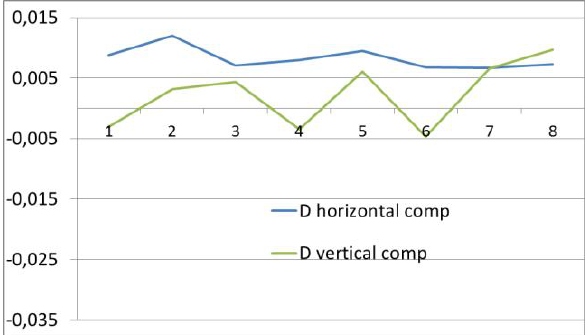
Figure 17. Coordinates differences [m] – mass market receiver and geodetic antenna in stop & go